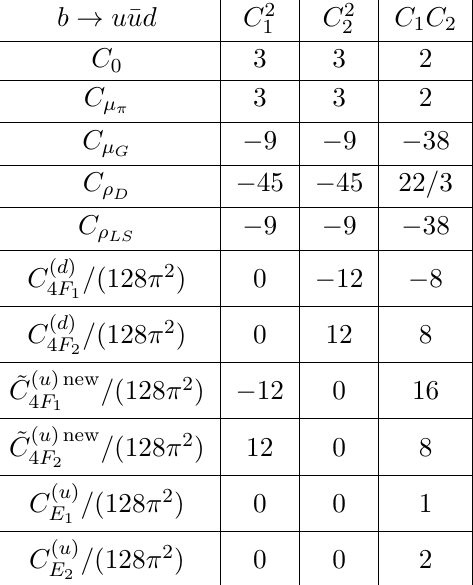
Table 2 . Numerical values for the coefficients of b → u ¯ ud in the canonical basis ( a = 4 , b = − 4